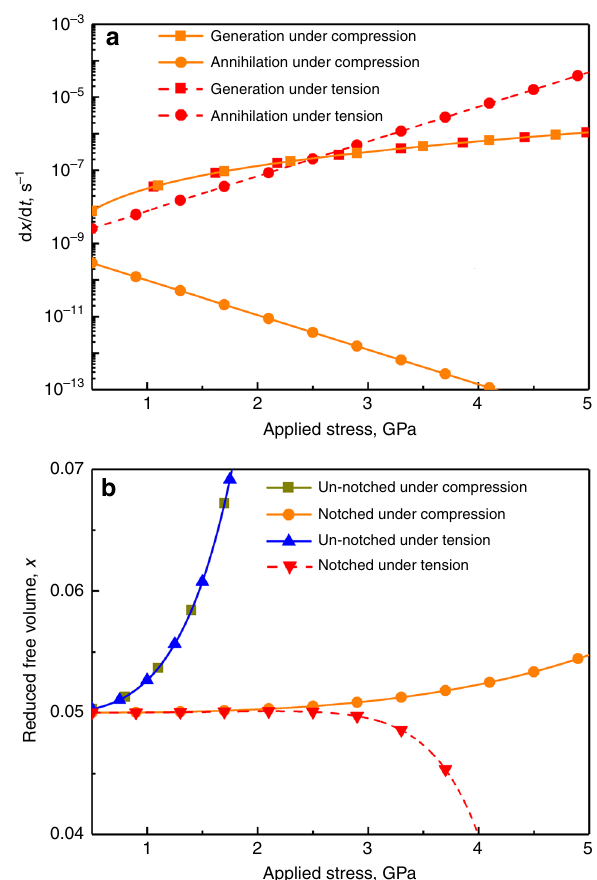
Fig. 7 Effect of stress state on the evolution of free volume. a The generation and annihilation rates of free volume in a notched BMG specimen as a function of applied axial compressive or tensile stress. b The evolution of reduced free volume x in a notched BMG specimen as a function of applied compressive or tensile axial stress. The values for an un- notched specimen are included for